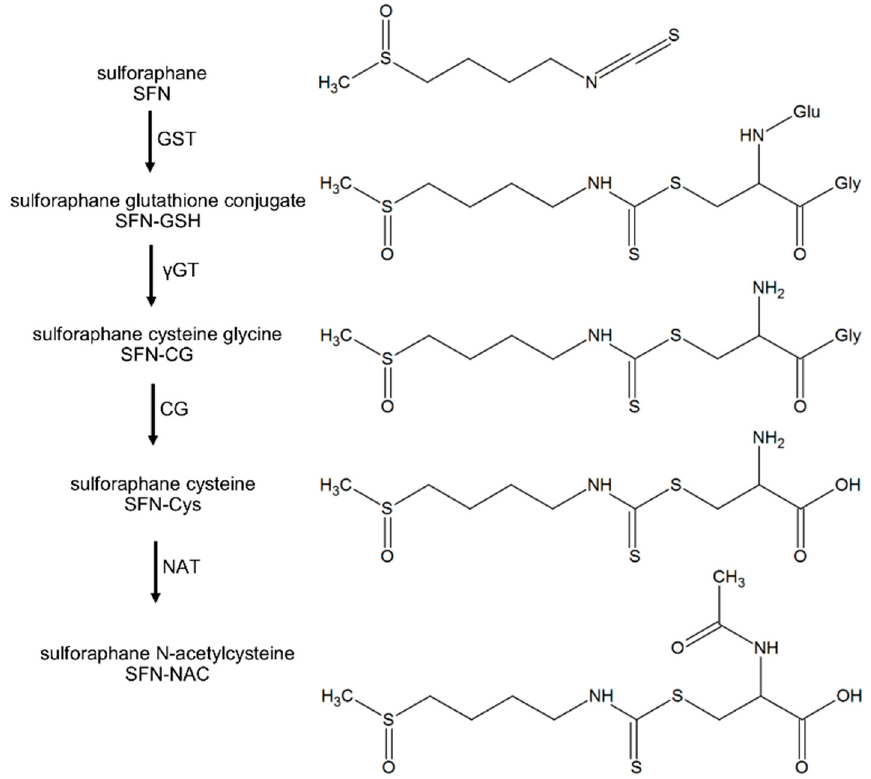
Figure 1. The mercapturic acid pathway of sulforaphane (SFN). GSTs, glutathione S-transferases; γ -GT, γ -glutamyl transferase; CG, cysteinylglycinase; NAT, N -acetyl transferase. Structures adopted from [7] and created using ACD/ChemSketch (Version C40H41, Advanced Chemistry Development, Inc., Toronto, ON, Canada).